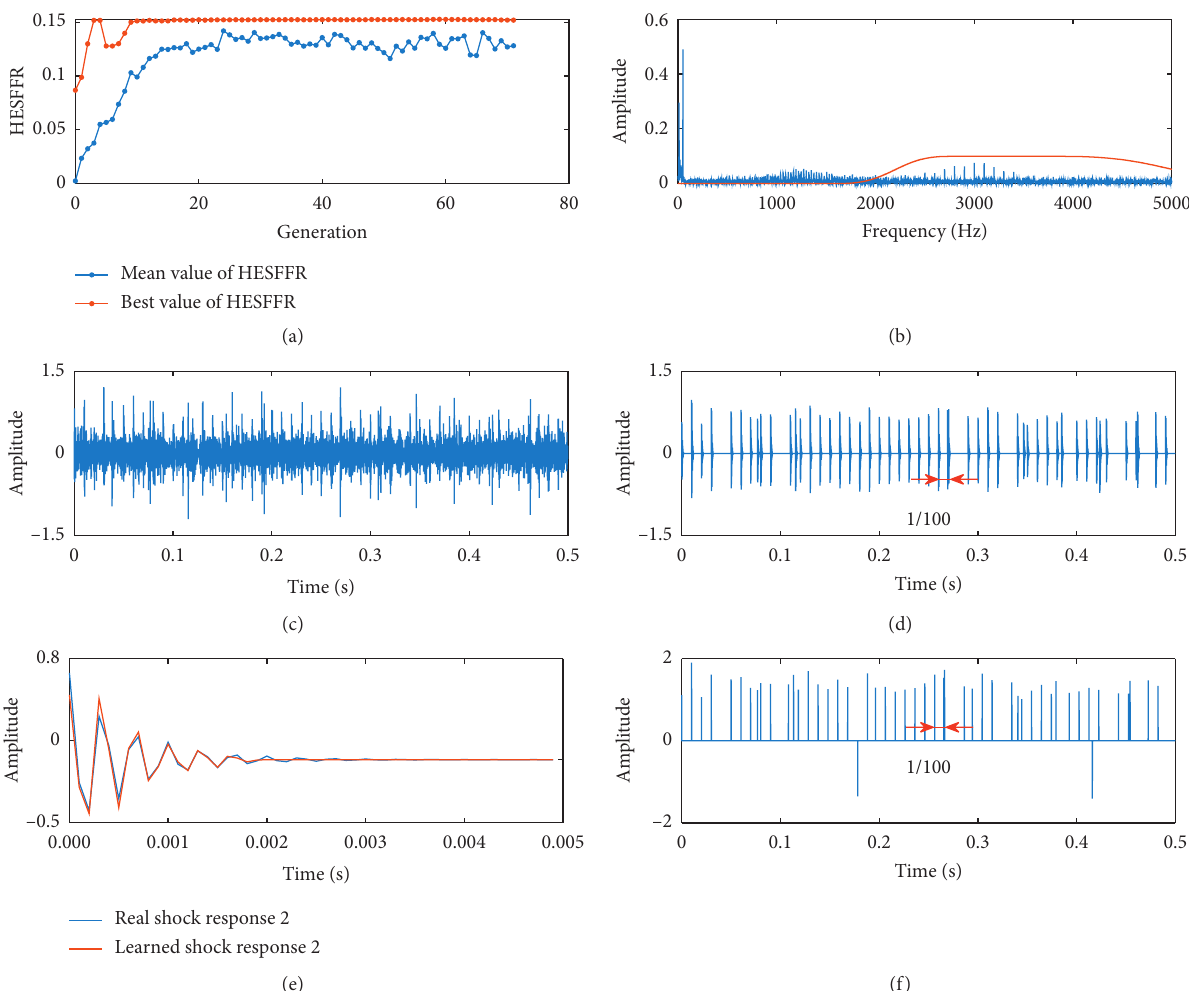
Figure 11: AUC-DLA-OB for detection of fault impulses with the fault characteristic frequency of 100Hz. (a) Convergence process of solving constrained optimization problems; (b) filtering frequency band related to fault impulses; (c) filtered signal by filters in Figure 11(b); (d) sparse reconstruction signal; (e) learned shock response 2; and (f) location coefficients obtained from simulation